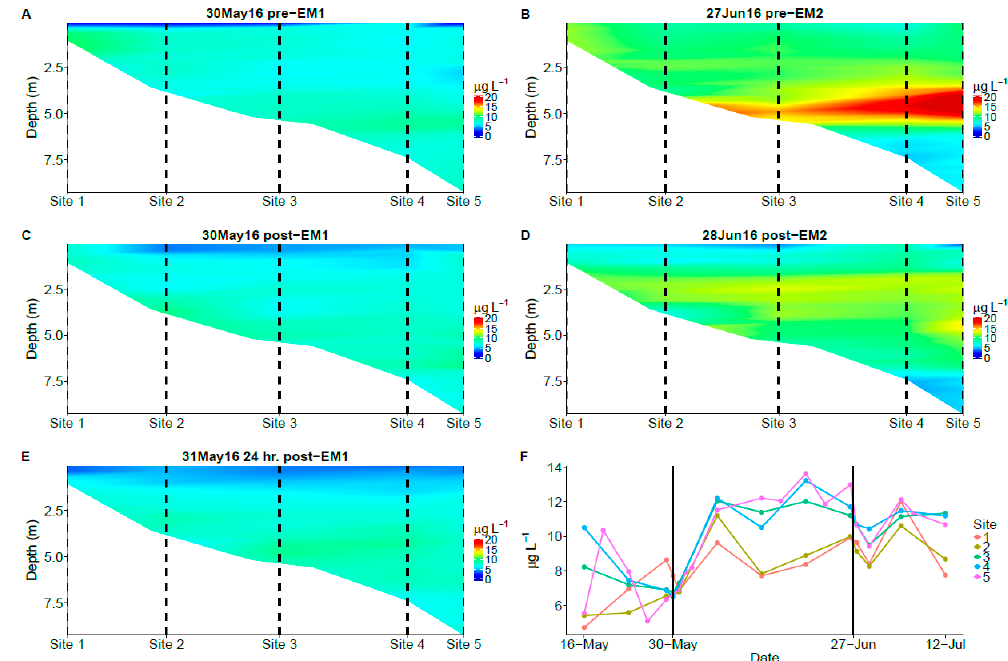
Figure 6 . ( A – E ) Longitudinal profiles of FCR ( A ) immediately before EM1, ( B ) immediately after EM1, ( C ) 24 h after EM1, ( D ) immediately before EM2, and ( E ) immediately after EM2. Vertical dashed lines represent where FluoroProbe profiles were taken. Location of Sites 1–5 can be found on the inset map of Figure 1. ( F ) Mean phytoplankton biomass across the top 5.5 m of the water column (or the full water column if shallower than 5.5 m) at all sampling sites in FCR during the monitoring period. Solid vertical lines denote mixing events.